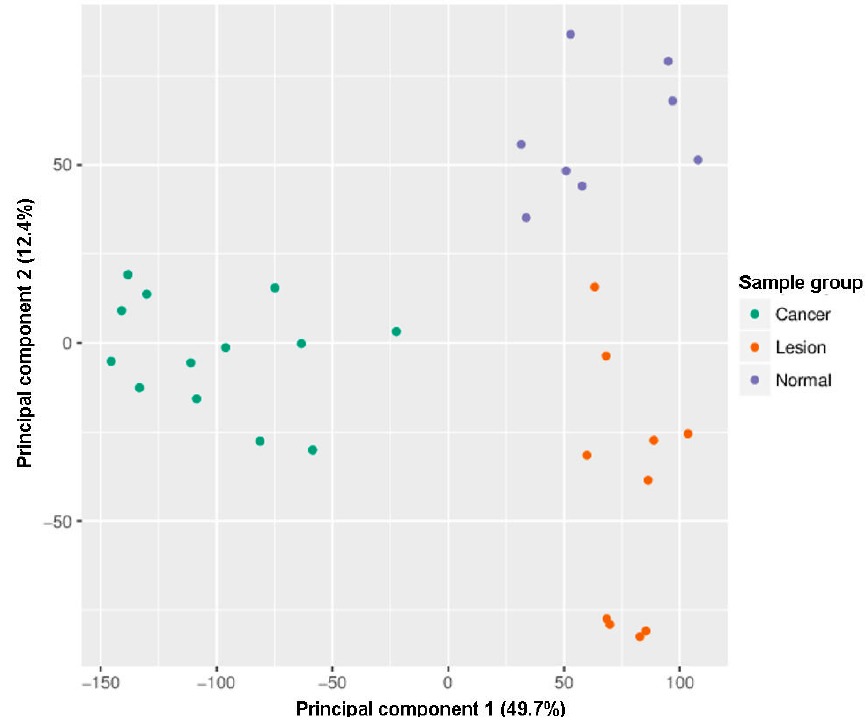
Figure 1. Infinium MethylationEPIC BeadChip findings: Samples grouping by the principal component. Green: Head and neck squamous cell carcinoma (HNSCC) samples, oropharyngeal cancer ( n = 6) and oral cancer ( n = 7), orange: Oral lesions, OLP ( n = 8) and OLL ( n = 2), violet: Healthy oral mucosa ( n = 8).